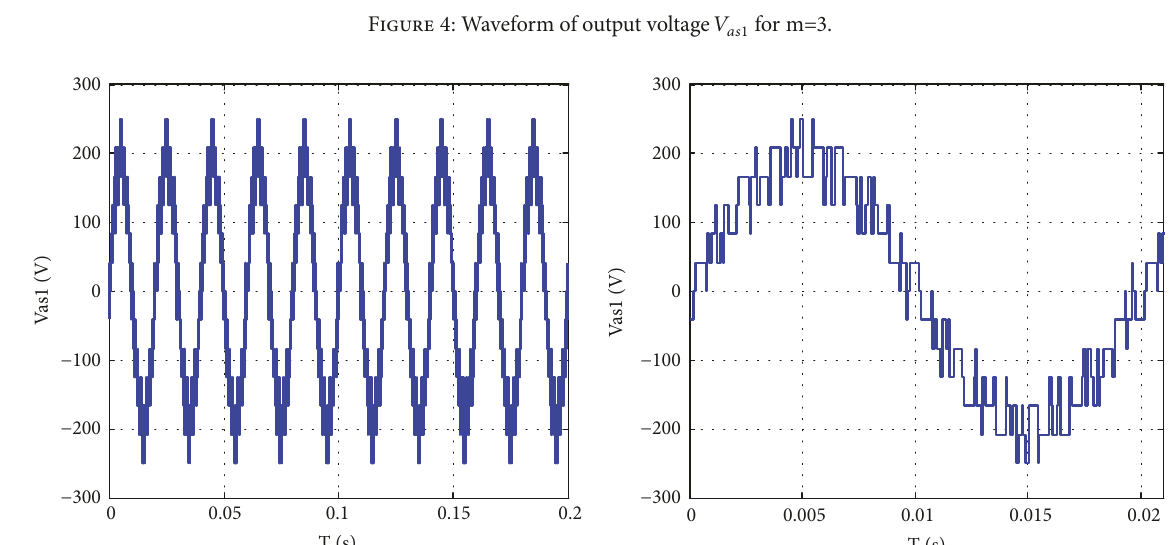
Figure 5: Waveform of output voltage 𝑉 𝑎𝑠1 for